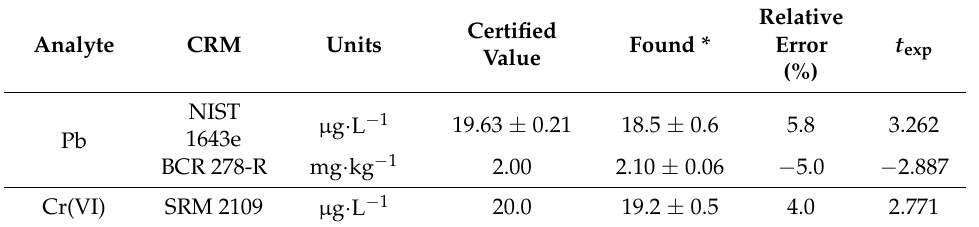
Table 4. Analytical results for lead and chromium(VI) determination in CRMs.